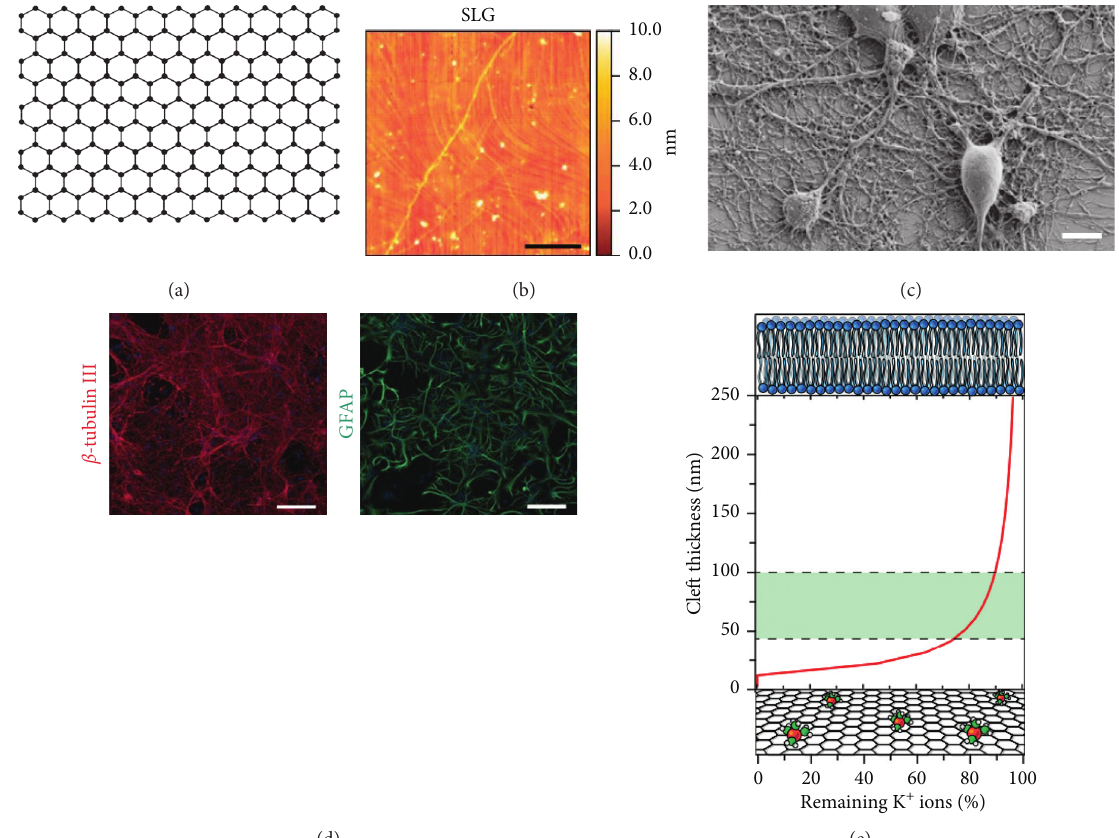
Figure 3: (a) Molecular representation of graphene [37]. (b) AFM topography of single-layer graphene (SGL, scale bar: 5 μ m). (c) Scanning electron micrograph depicting hippocampal neuron morphology cultured onto SLG (scale bar: 10 μ m). (d) Fluorescent microscopy images showing dissociated hippocampal networks labelled with class III β -tubulin (for neurons) in red and GFAP (for astrocytes) in green (scale bar:100 μ m). (e) Sketch of the local amount of K+ depletion in the space between the cell membrane and the SLG surface (membrane/surface cleft) due to graphene trapping as function of cleft thickness. The light green region shows the extrapolated K+ depletion values (red line) within the range of the estimated cleft dimensions (40–100nm). See Reference [35] for more